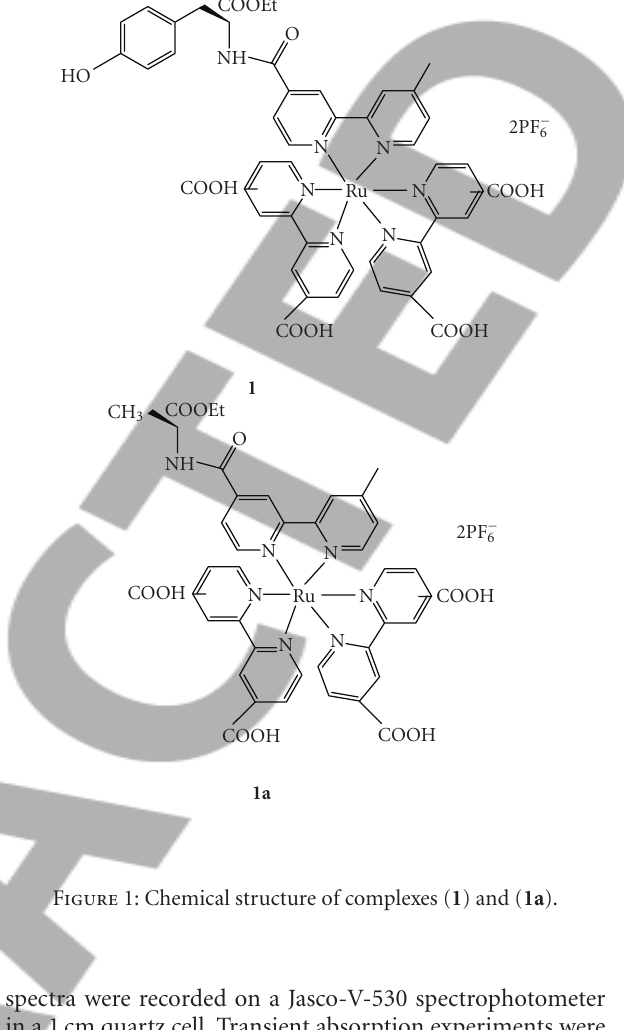
Figure 1: Chemical structure of complexes ( 1 ) and ( 1a